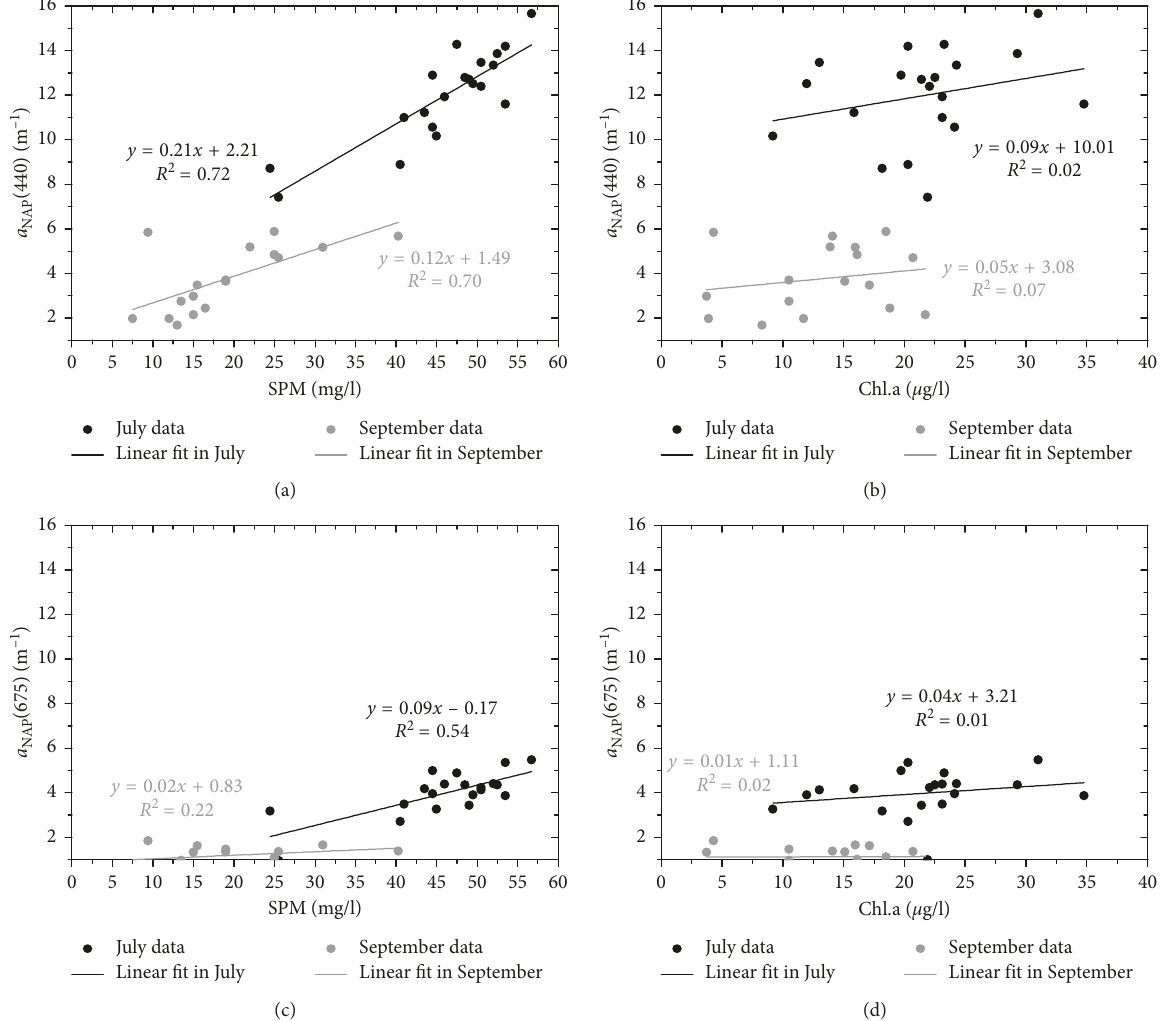
Figure 5: The linear relationships of a NAP (440) and a NAP (675) with SPM and Chl.a concentrations.